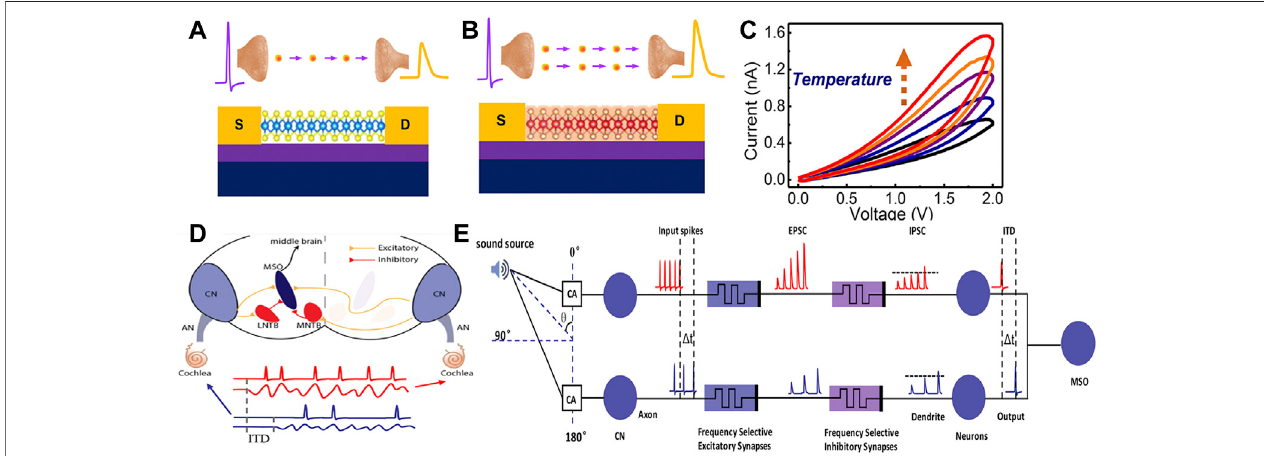
FIGURE 8 | (A) Schematic diagram oftwo-terminal MoS (B) Schematic diagram of a Joule-heated MoS (C) 2 device without Joule heating. 2 double-ended device. Jouleheating-drivenconductance(G)Facilitationwithmultiplevoltagesweeps. (D) SchematicpictureforsoundlocalizationwithbothITDandILD. (E) Schematicpicture of the working mechanism of synaptic computation for ITD-based sound localization (adapted from Sun et al., 2018).